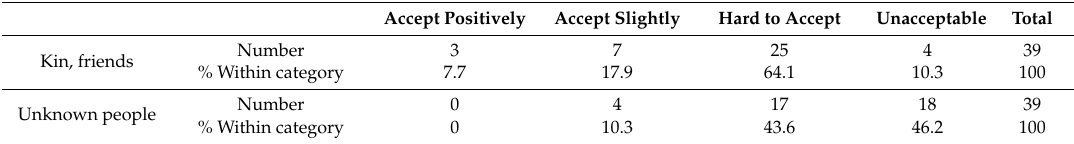
Table 4. Proportion of migrant acceptability.